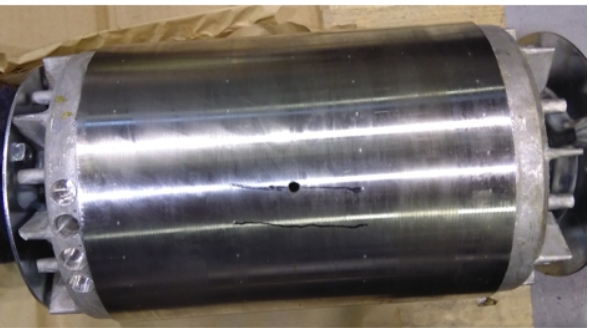
Figure 6. An artificially made fault in the rotor bar on the loading motor.